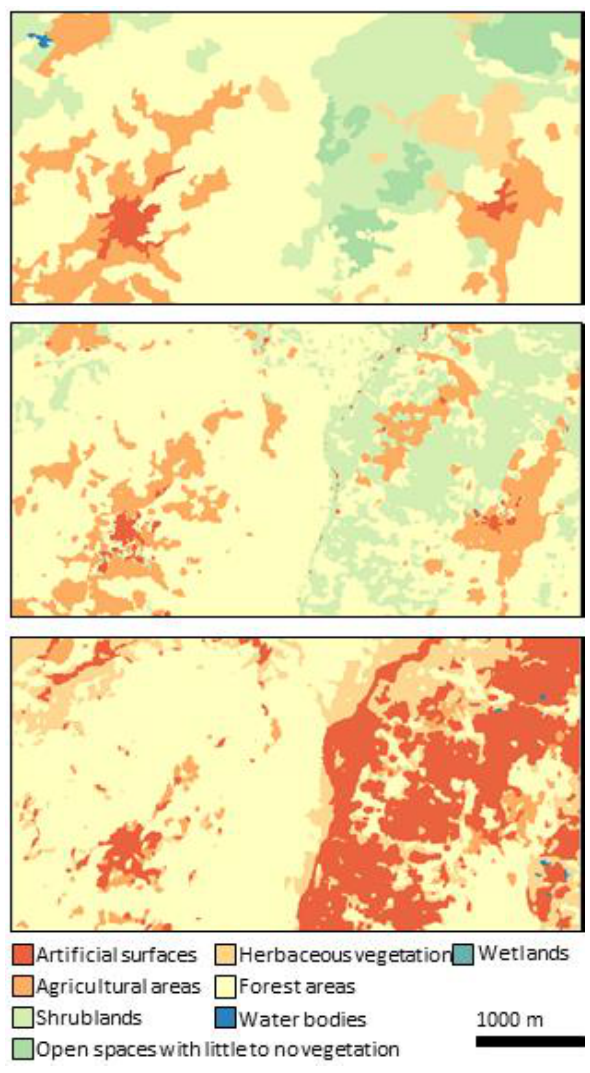
Figure 7. Results when testing in SENP study area. Top: COS2018, used as reference; Middle: Training with SENP data; Bottom: training with